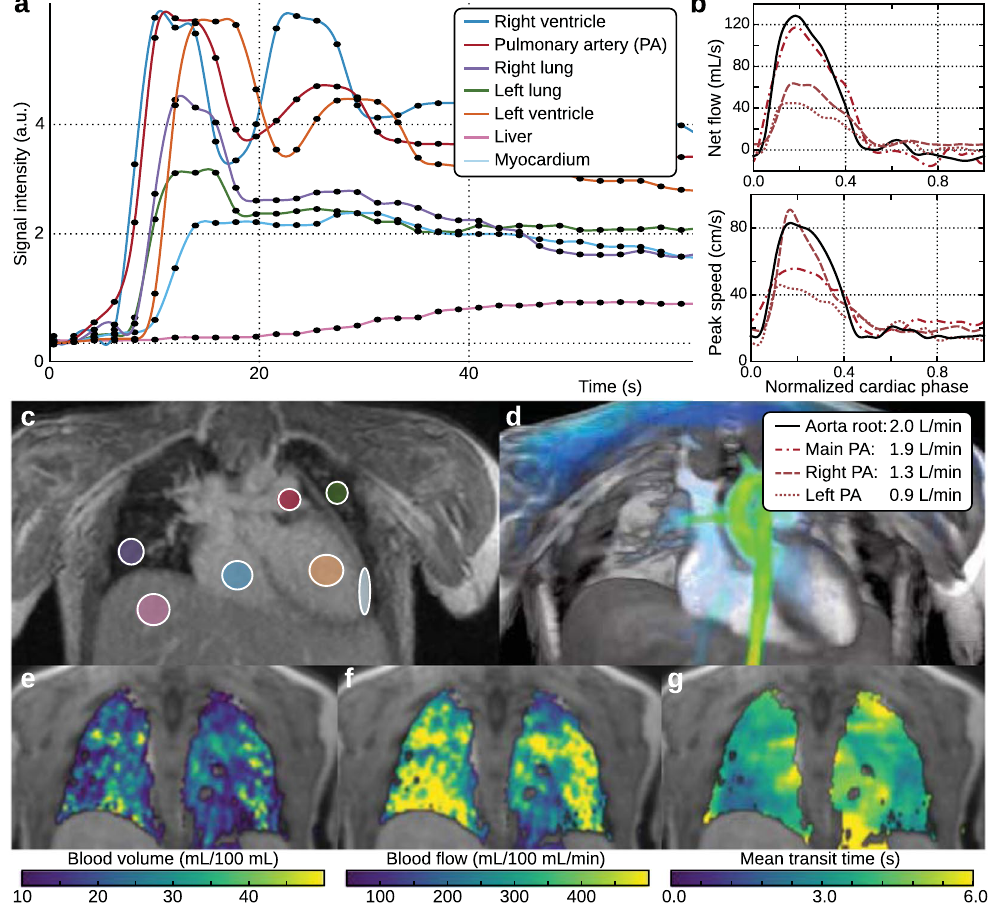
Figure 6. Dynamic-contrast-enhancement/perfusion reconstruction with XD flow of a 2-year-old male with the administration of gadobutrol. Contrast dynamics (2-s temporal resolution) of specific tissues are depicted in ( a ) with the corresponding ROI drawn in ( c ). The same dataset can also be reconstructed to depict flow information as plotted in ( b ) and visualized in ( d ). In ( a ), the initial enhancement of the right ventricle can be seen with the initial peak. The contrast recirculating through the system can be observed with the secondary peak. Pulmonary enhancement can be seen with the ROIs drawn on the right and left lungs. Pulmonary perfusion maps are displayed as pulmonary blood volume ( e ), pulmonary blood flow ( f ), and mean transit time ( g ). The enhancement of the lungs is after the enhancement of the right ventricle and pulmonary